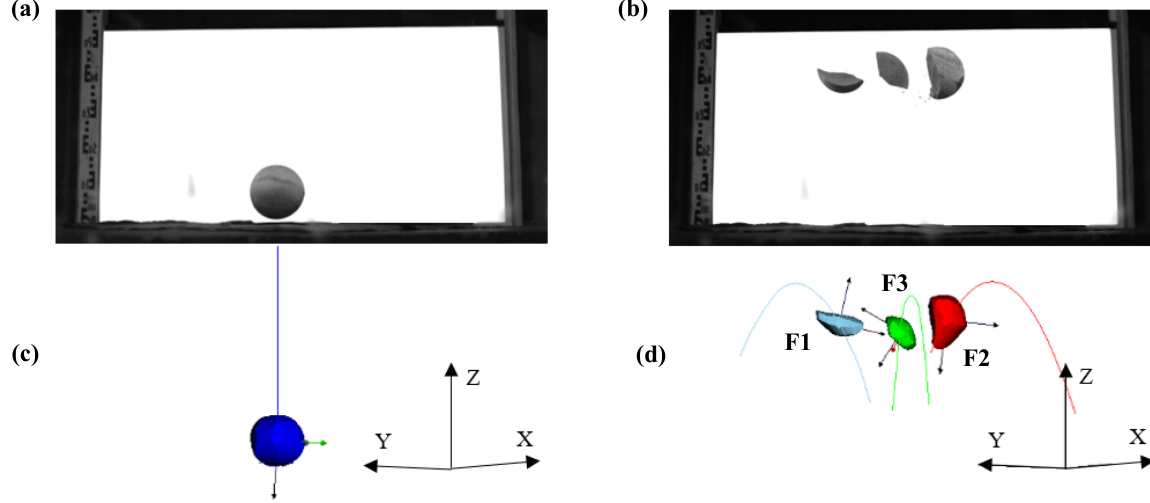
Figure 12. Example of a drop test with frame recorded by a high-speed camera showing (a) the falling sphere before impact and (b) the flying fragments after impact, with corresponding tracking analysis showing the visual hulls and trajectories of (c) the sphere and (d) the major three